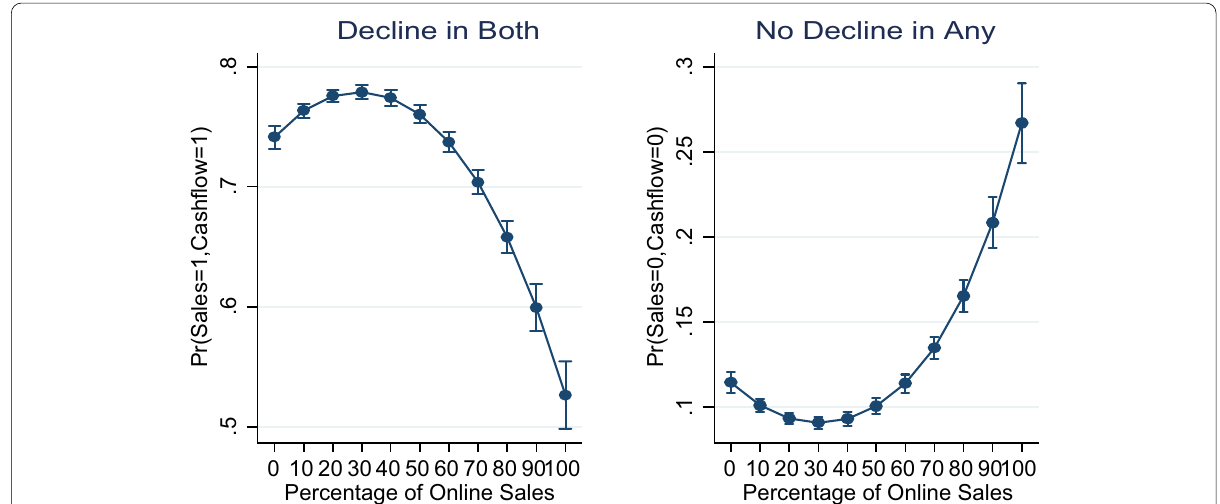
Fig. 2 Predictive margins plot of sale and cash-flow decline. Source : authors’ construct based on Covid-19 ES follow-up survey (2022)